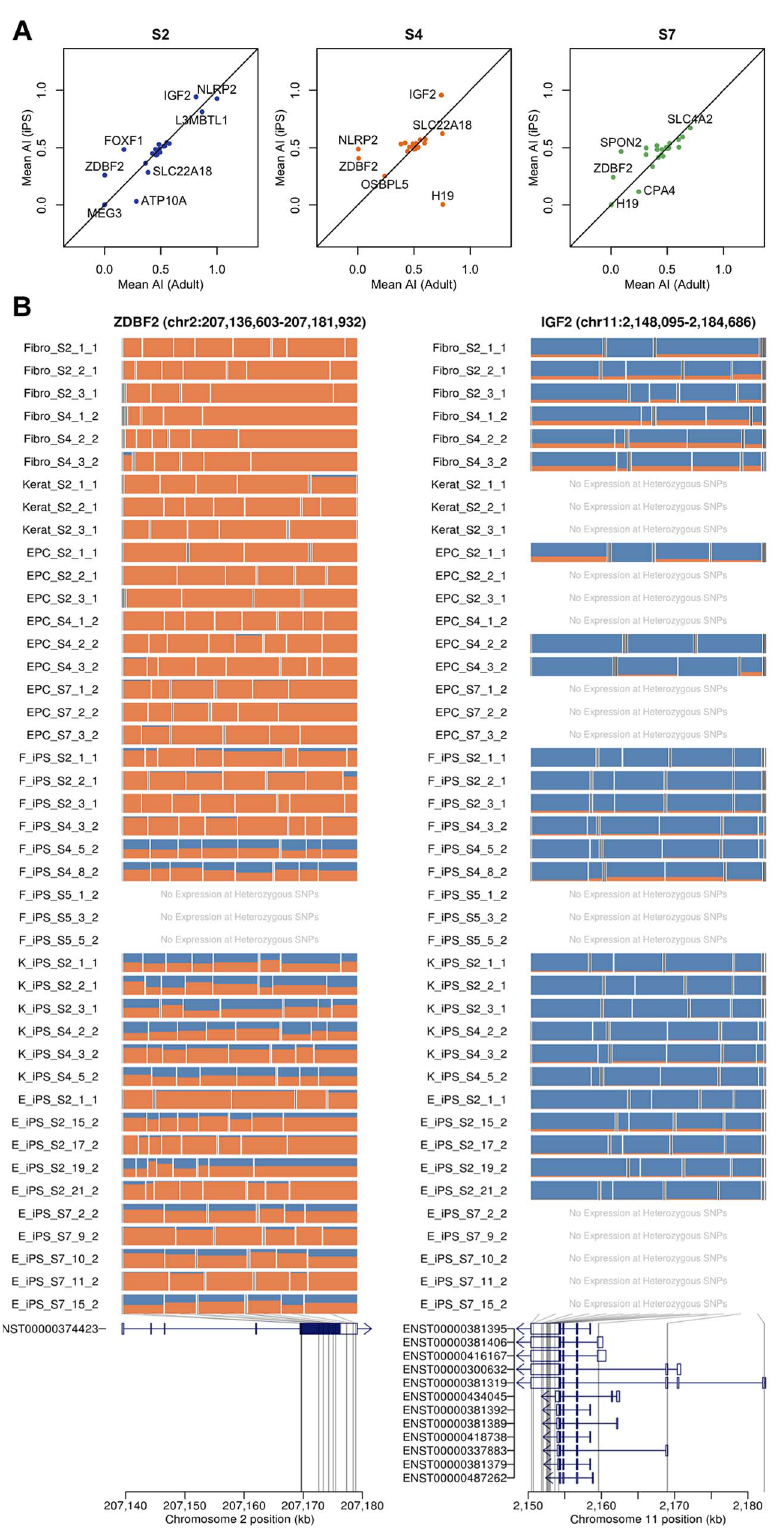
Figure 3. Imprinting effects on transcription in adult and iPS cells. (a) Allelic imbalance between adult cells and iPS cells for each donor (S2, S4 and S7). (b) The mosaic plots for each cell line show the allelic imbalance at multiple heterozygous SNP loci throughout the transcribed region. Each row corresponds to a sample, and each box corresponds to a single heterozygous SNP. Box width is proportional to the total nucleotide count at the heterozygous SNP, with the box bisected in proportion to the paternal and maternal nucleotide counts (blue and orange) based on the phasing haplotype information. Examples show consistent loss of imprinting in iPSCs (ZDBF2) and in adult cells (IFG2).